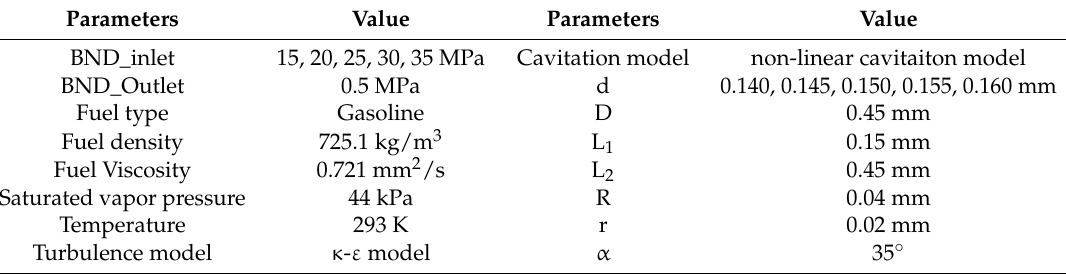
Figure2. Structural parameters of the GDI injector nozzle. Table 1. Boundary conditions, nozzle sizes, and mathematical models.